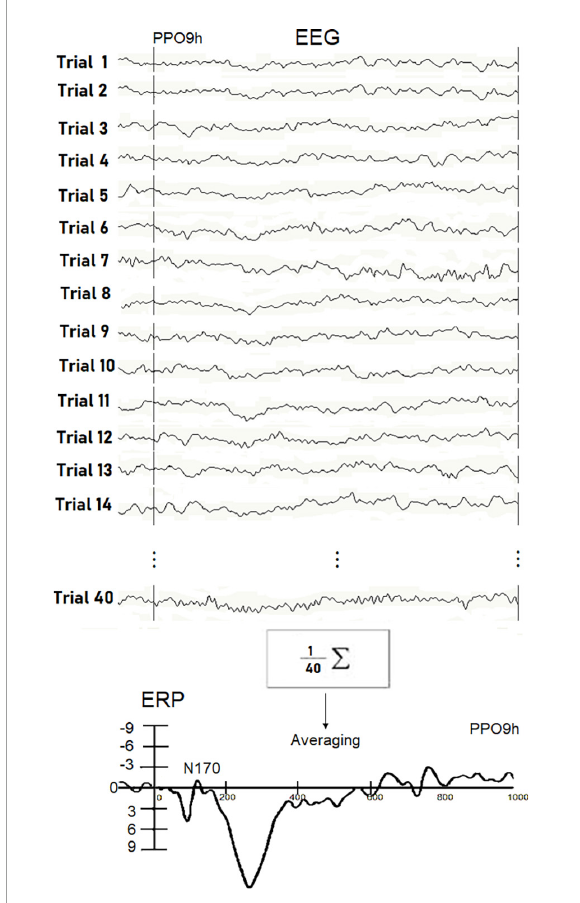
FIGURE2 Examples of real EEG trials recorded in response to visually presented words in individual Ss5. The N170 peak reflecting orthographic processing was extracted throughout the averaging procedure since it was hidden in the EEG signals. Unlike P300, the detection of small potentials is not possible through single trial analysis. The waveform recorded in the Ss5 in response to written words at the PPO9h site is displayed at the